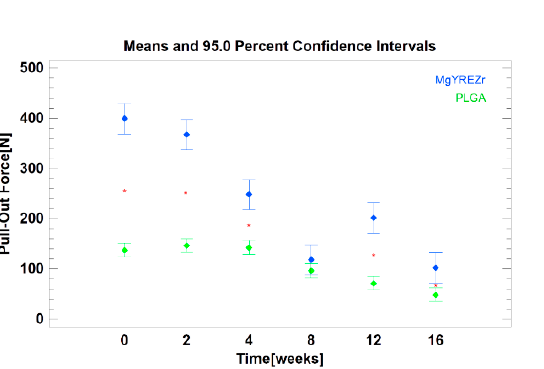
4 of 11 Figure 1. Appearance of samples used in the resorption experiment: magnesium alloy screws on the left-hand and poly(lactic-co-glycolic acid) screw on the right-hand side. All screws had a length of 14 mm. Their length did not change